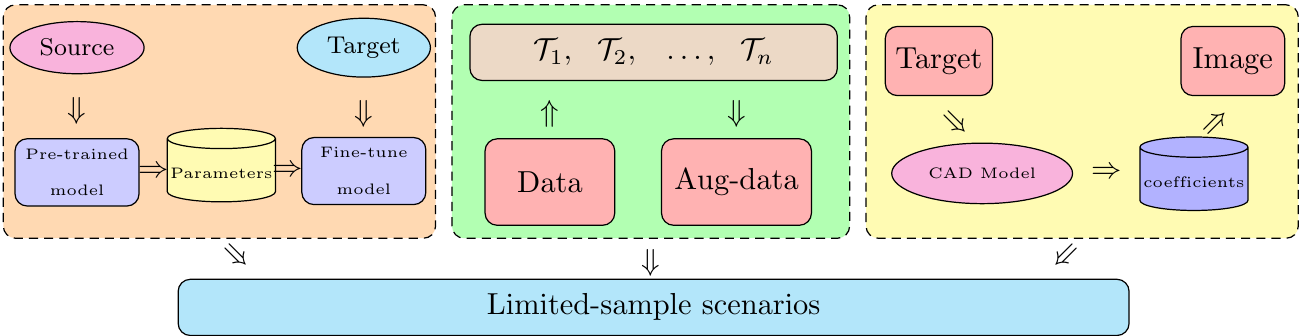
Figure 1. Three typical solutions for limited-sample scenarios. Transfer learning, data augmentation and image